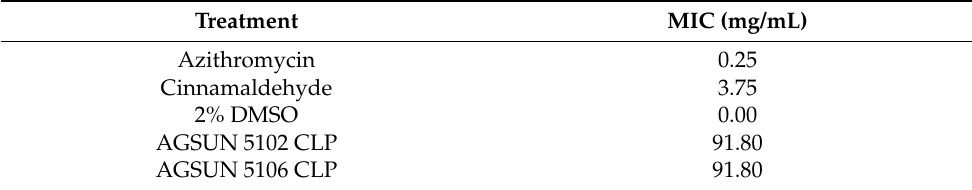
Table 1. Minimum inhibitory concentrations of the treatments on P. aeruginosa .